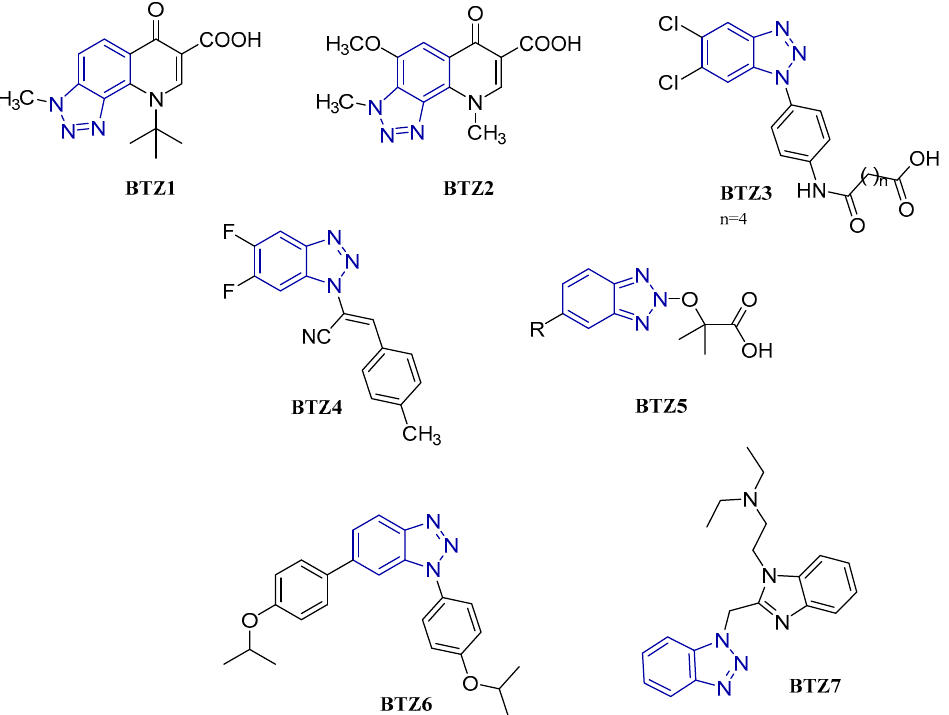
Figure 1. Previously reported benzotriazole-based compounds with biological activities, BTZ1 [41], BTZ2 [42], BTZ3 [43], BTZ4 [44], BTZ5 [46], BTZ6 [47], BTZ7 [48].